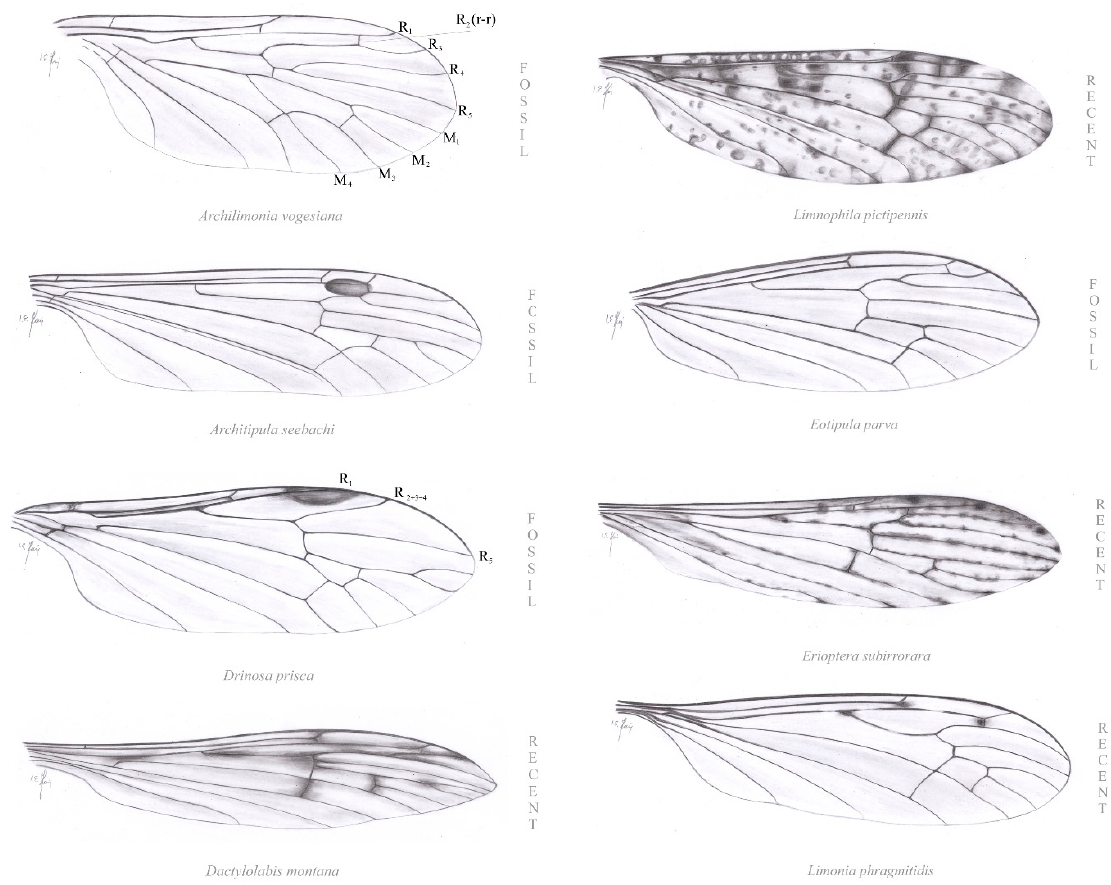
Figure 8. Wing venation of: Archilimoniidae: Archilimonia vogesiana Krzemi ń ski et Krzemi ń ska, 2003 [11], (redrawn after